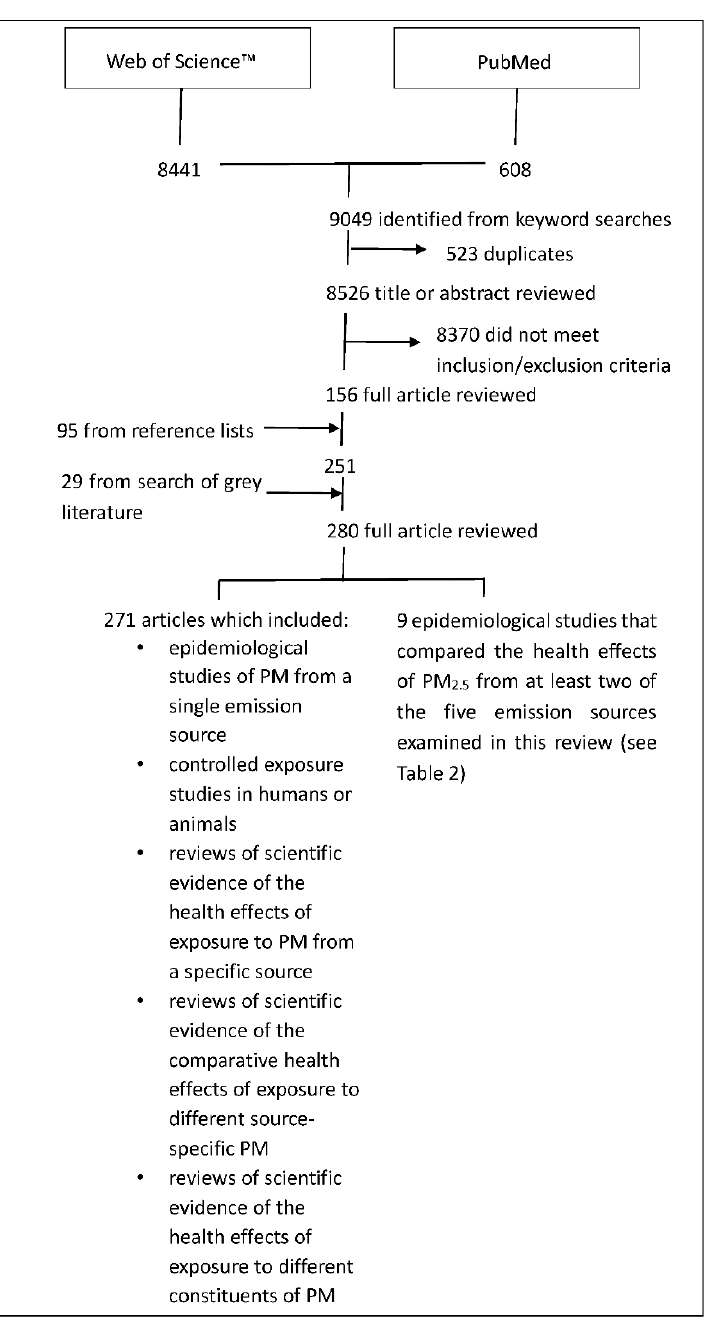
Figure 1. Results of search of scientific databases.